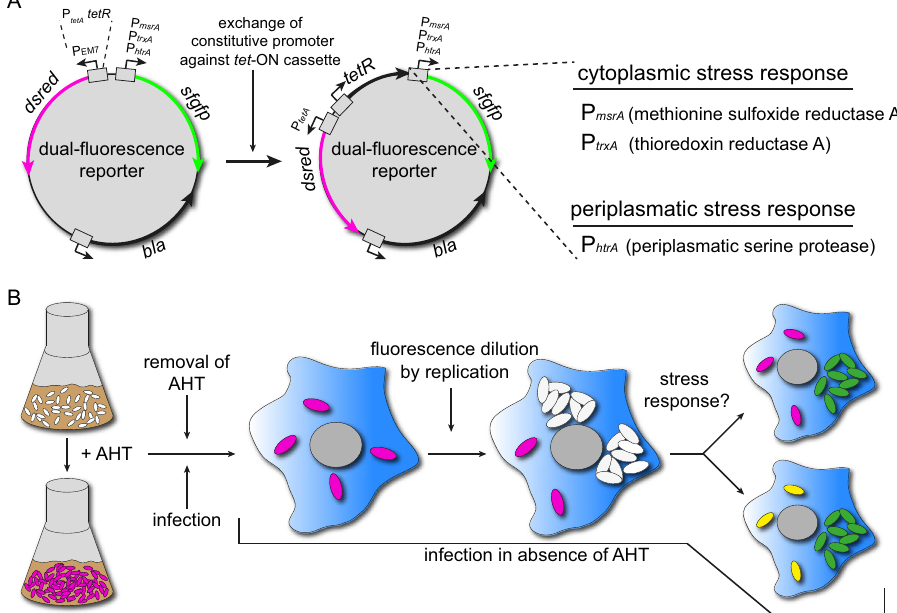
Fig. 1 Design of reporters to measure stress response of non-replicating STM. A For detection of NR intracellular STM, the EM7 promoter of dual FP reporters for msrA , trxA , or htrA was replaced by the tet-ON cassette to enable controlled induction of dsred expression by AHT. B Addition of AHT to growing cultures of STM induced DsRed synthesis. Before infection of macrophages, AHT was removed by centrifugation and washing. Infection was performed in absence of AHT. After infection, intracellular R STM dilute cellular DsRed levels. NR intracellular STM maintain cellular DsRed levels and were detected as DsRed-positive events. In addition, the msrA -induced sfGFP intensity provides information about response to stress imposed by the host